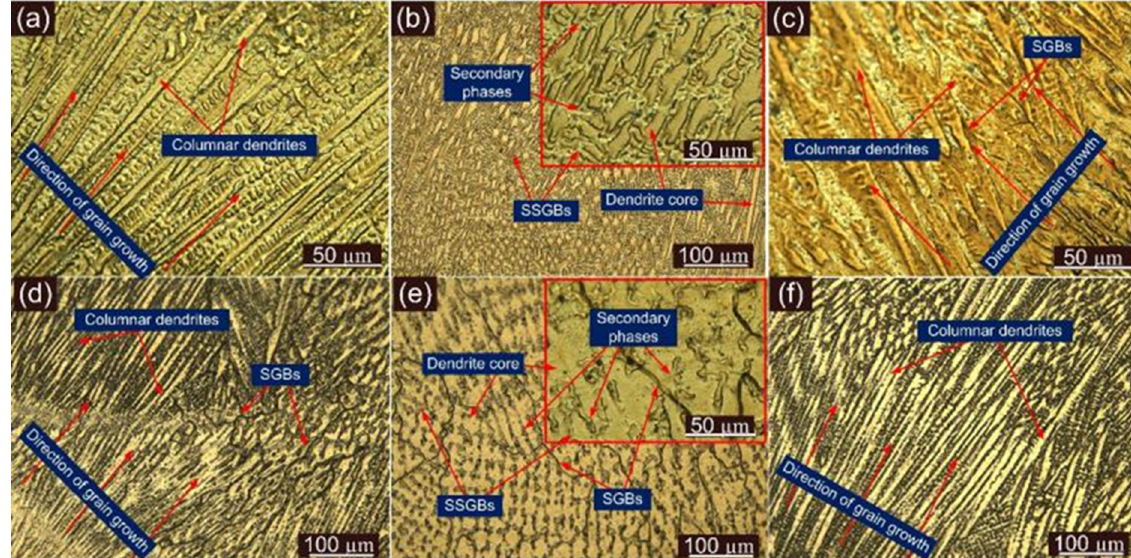
Figure 5. Typical optical micrograph of the ERNiCrMo-3 weld metal near the interface and in the interior region for AW joint: ( a ) ERNiCrMo-3 weld metal near P91 interface; ( b ) interior region of the bulk weld metal, ( c ) near P22 interface; after PWHT: ( d ) ERNiCrMo-3 weld metal near P91 interface, ( e ) interior region of the bulk weld, ( f ) near P22 interface.